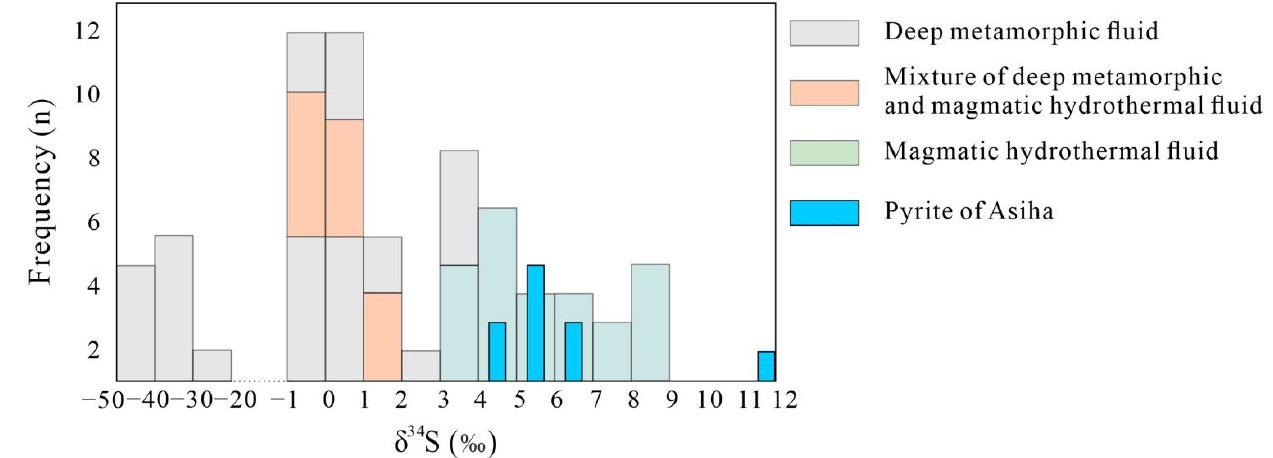
Figure 7. Histogram of sulfur isotopic compositions of pyrite from the Asiha gold deposit, the source of fluid data after Wulonggou deposit [54].